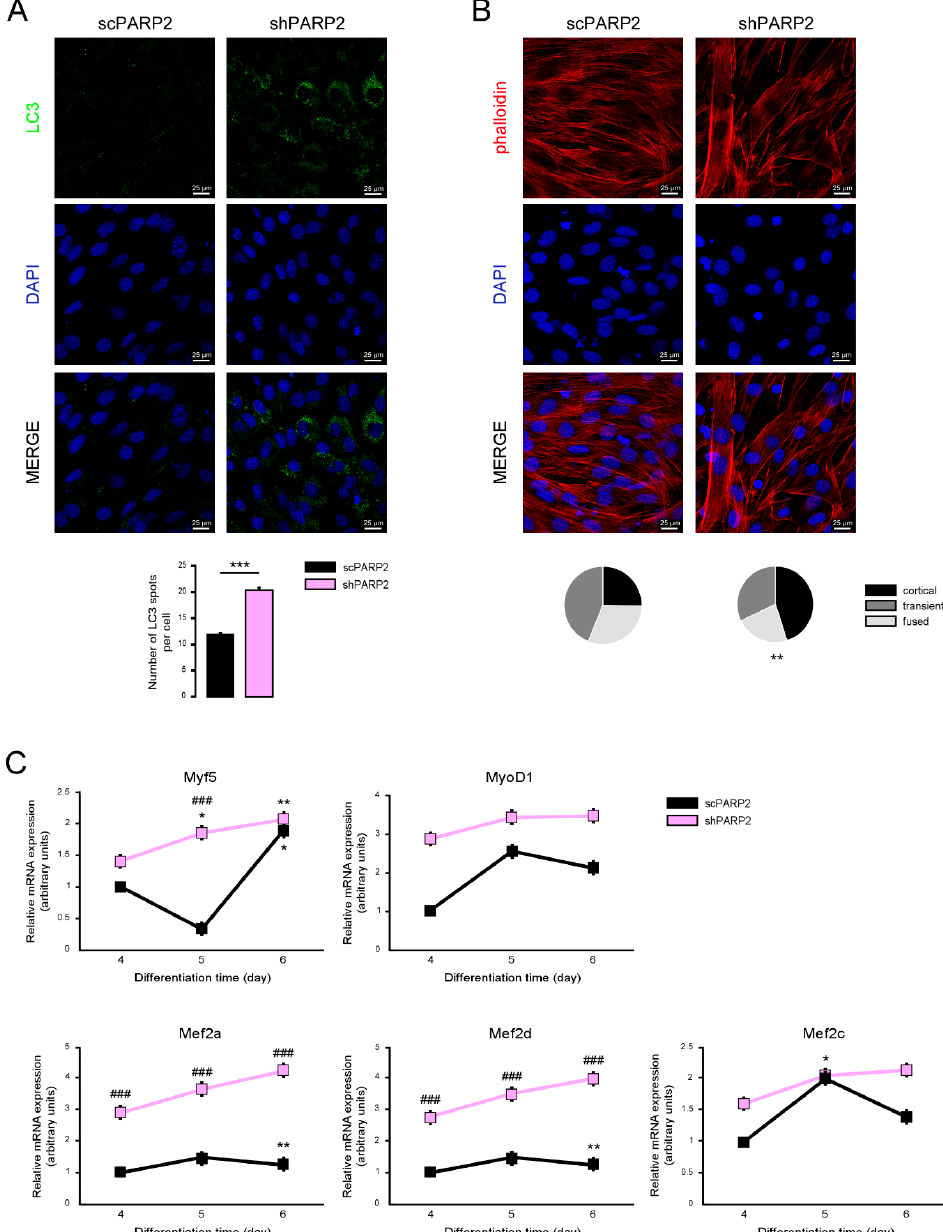
Figure 12. Silencing of PARP2 supports myogenic differentiation. A total of 20,000 scPARP2 and shPARP2 C2C12 cells were seeded in 24-well plates that were di ff erentiated for 4 days then ( A ) LC3-positive vesicles were assessed by immunofluorescence, ( B ) actin cytoskeleton was stained by Texas Red-X Phalloidin + DAPI, and ( C ) the expression of a set of myogenic genes were assessed by RT-qPCR. On panel B 100 / 100 cells were scored for the structure of actin cytoskeleton as di ff use, transient, and strong cortical staining. *** represent statistical di ff erence between scPARP2 and shPARP2 cells at p < 0.001 on panel A. ** represent statistical di ff erence between scPARP2 and shPARP2 cells in terms of actin morphology at p < 0.01 on panel B. In panel C, ### represents statistically significant di ff erences between the scPARP2 and shPARP2 cells at p < 0.001. * and ** represent statistically significant di ff erences between the control and di ff erentiated cells at p < 0.05 and p < 0.01, respectively. For the determination of statistical significance, ANOVA test was used followed by Tukey’s post hoc test on panels A and C, while on panel B chi square test was